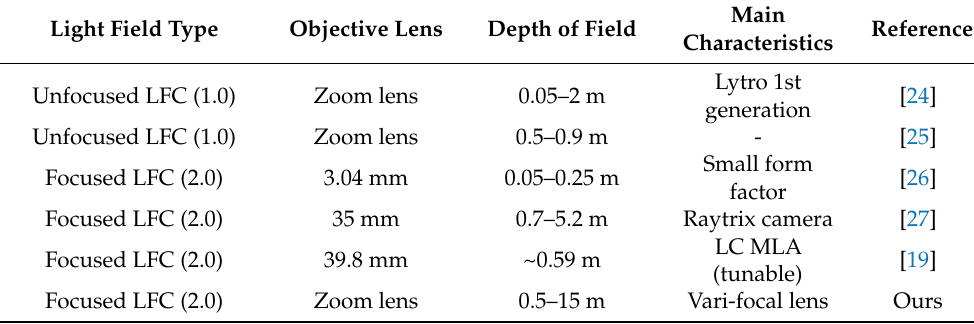
Table 3. Light field camera